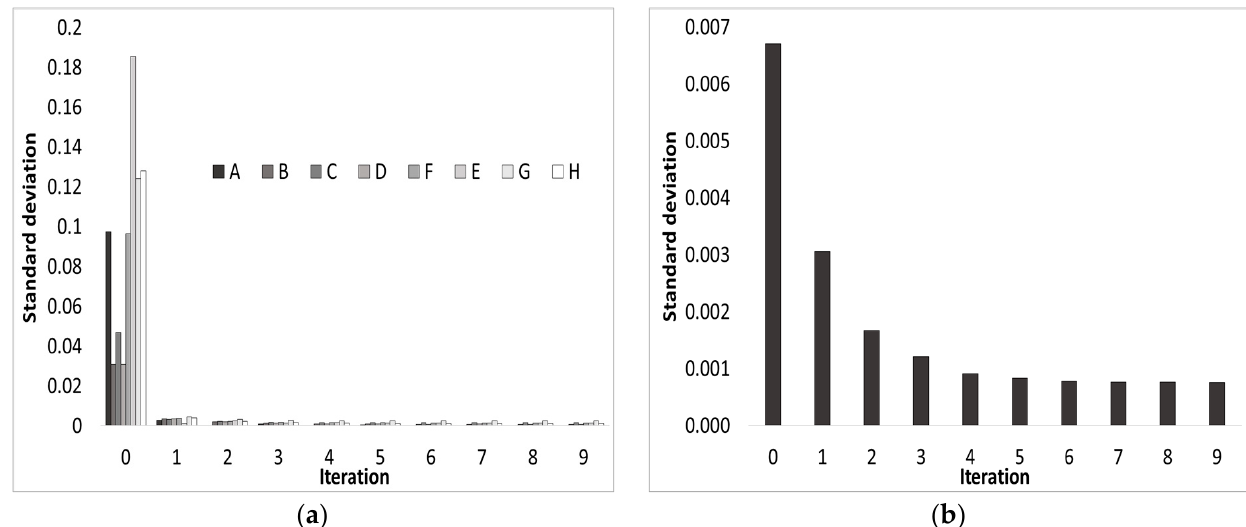
Figure 7. Difference ( a ) between the spatially averaged reflectance image and the spatially aver- aged ground truth and maximum error ( b ) between retrieved reflectance and ground truth as a function of the wavelength after each iteration steps.